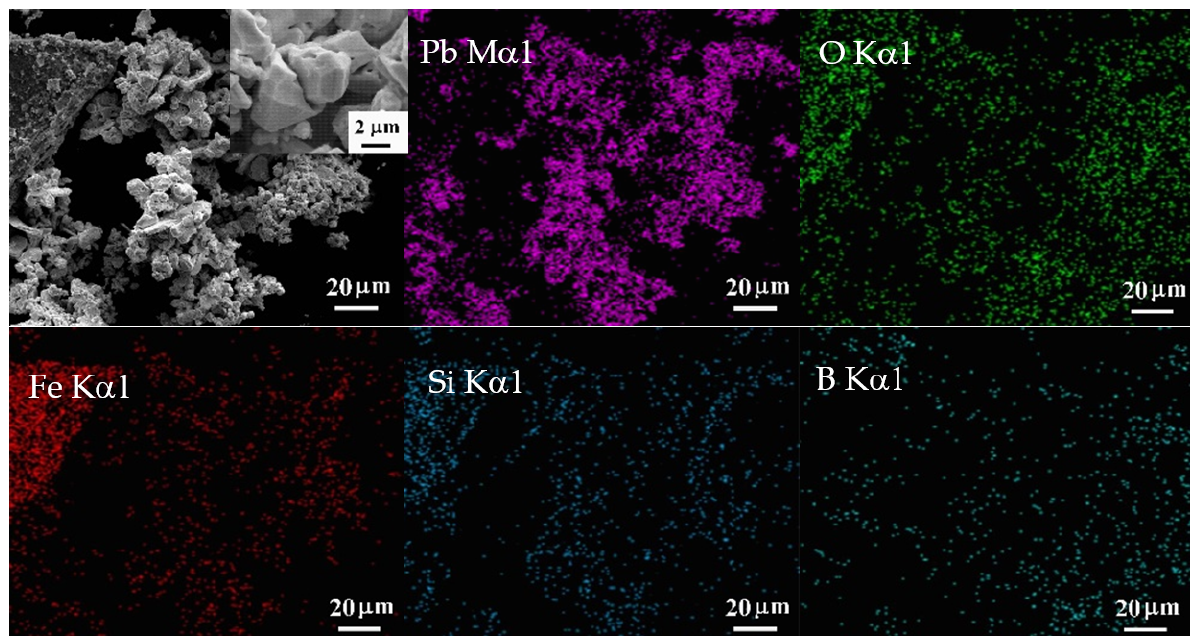
Figure 14. ( a ) SEM images with different magnifications of the reacted FeSiB BP and ( b – d ) enlarged views of the corresponding regions A, B, and C, respectively.